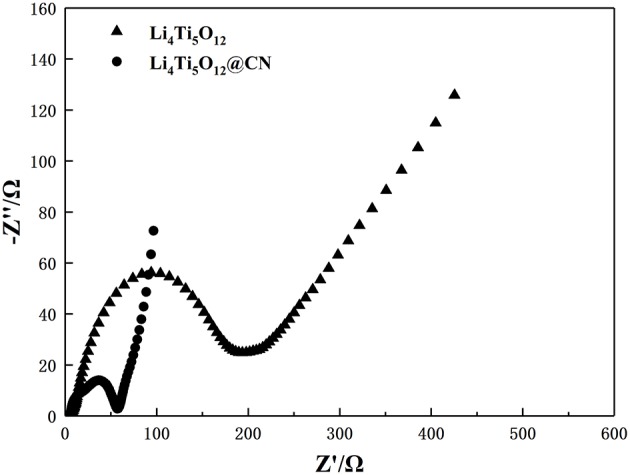
Nyquist plots of Li4Ti5O12 and Li4Ti5O12@CN composite.